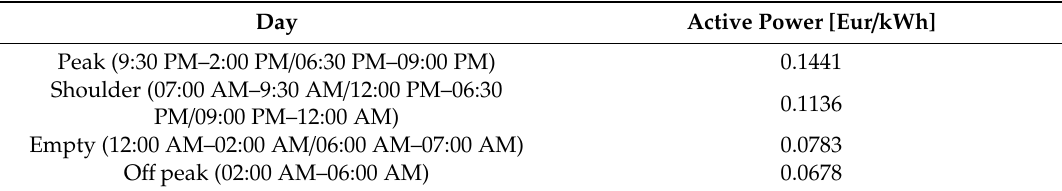
Table 6. Energy price according daytime [16].